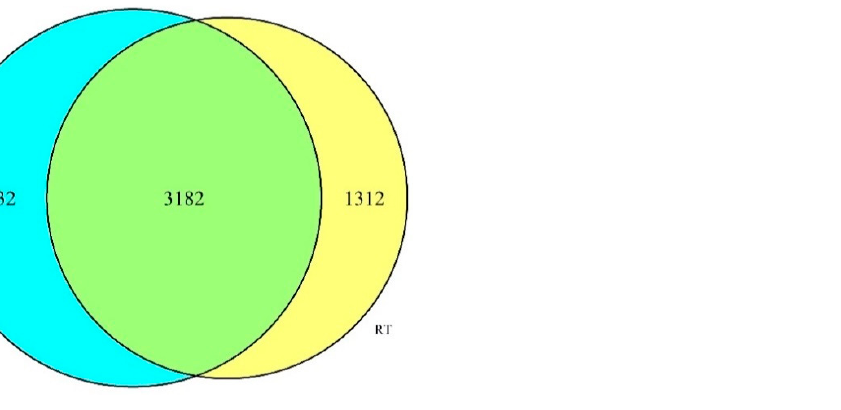
Figure 1. The numbers of shared and unique bacteria species OTUs obtained from soil of the residue retention (RT) and residue removal (RM) treatments. Table 2. Soil bacteria α -diversity indices for different thinning residue treatments. Simpson Chao1